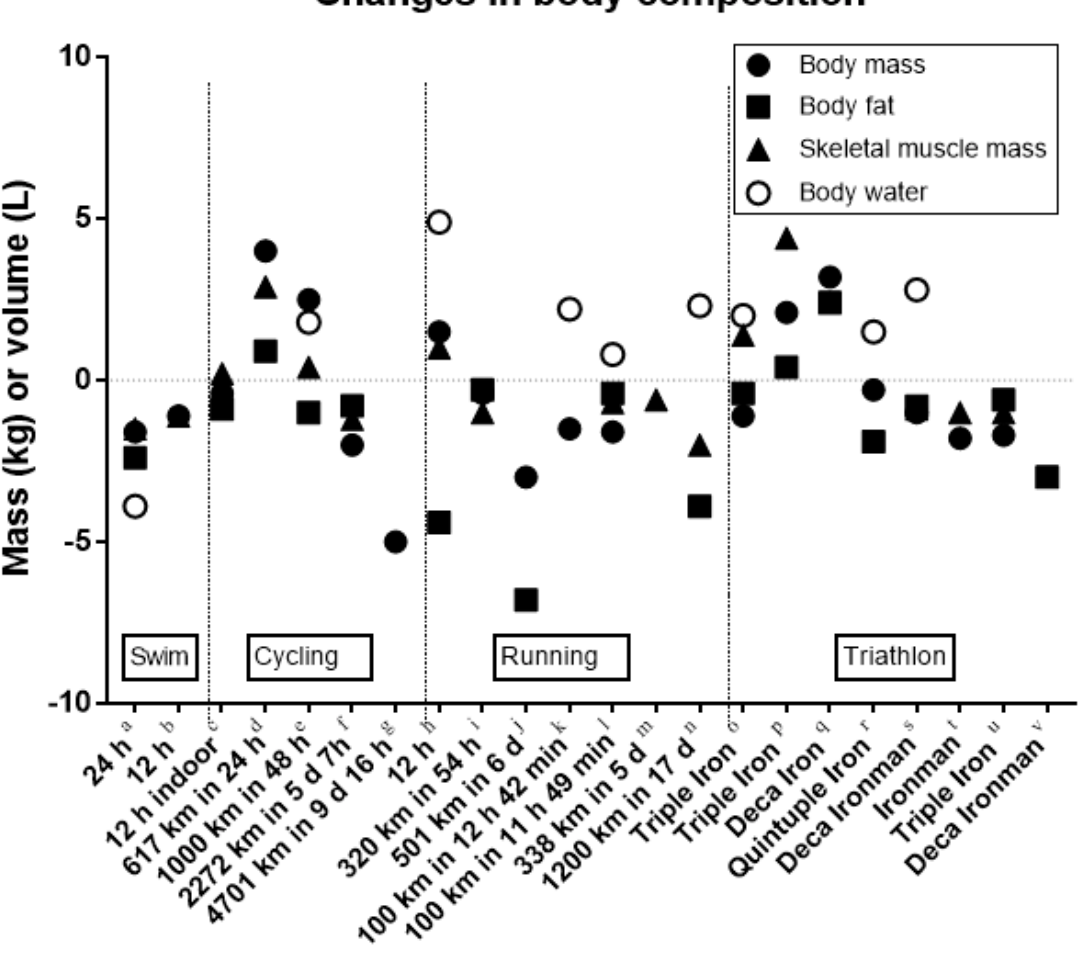
Figure 3. Change in body composition in ultra-endurance athletes competing in swimming, cycling, running, and triathlon. a = [25], b = [24], c = [26], d = [28], e = [32], f = [33], g = [11], h = [51], i = [34], j = [35], k = [37], l = [46], m = [48], n = [52], o = [39], p = [40], q = [53], r = [13], s = [42], t = [54], u = [55], v =